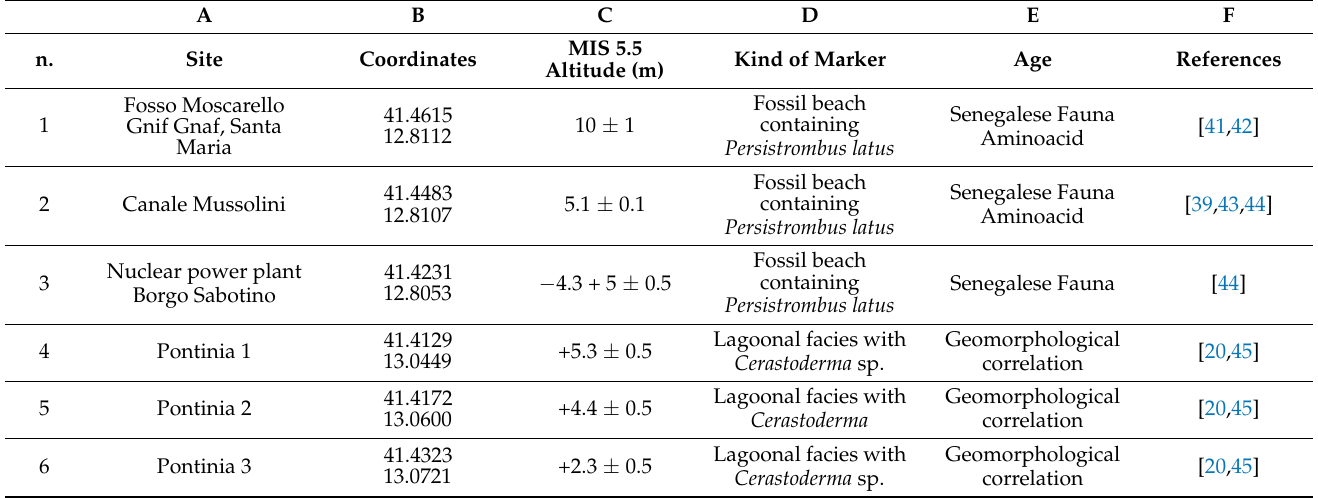
Figure 12. Main geological outcrops of the Pontina Plain, this map is a compilation of: (i) Italian Geological Survey sheet numbers 170, 158 and 159; (ii) map of the soil [40]; (iii) sinkhole map of Regione Lazio http://www.regione.lazio.it/binary/rl_main/tbl_documenti/AMB_PBL_Carta_Sink- holes_Lazio_2011.pdf. The red dots refer to the sites described in Table 3. Table 3. On this table all the outcrops dated to MIS 5.5 found studied in the Pontina Plain from Borgo Sabotino (NW) to the Piana di Fondi (SE) and the carbonate promontories of Sperlonga and Gaeta are listed (Figures 13 and 14). In particular, for the lagoon facies sites found in Section D of Figure 12 and published in [20] (Pontinia and Borgo Vodige), an infield check was carried out with respect to the presence of fossil deposits, their share and the fossiliferous association. Section E shows images of channels in the silty portion of the Pontina and Fondi Plain. The flow of the springs in conjunction with moments of high tide can lead to the deposition silts that are flooded and sometimes partially cover the MIS 5.5 fossil lagoon that extends inland for tens of kilometers.